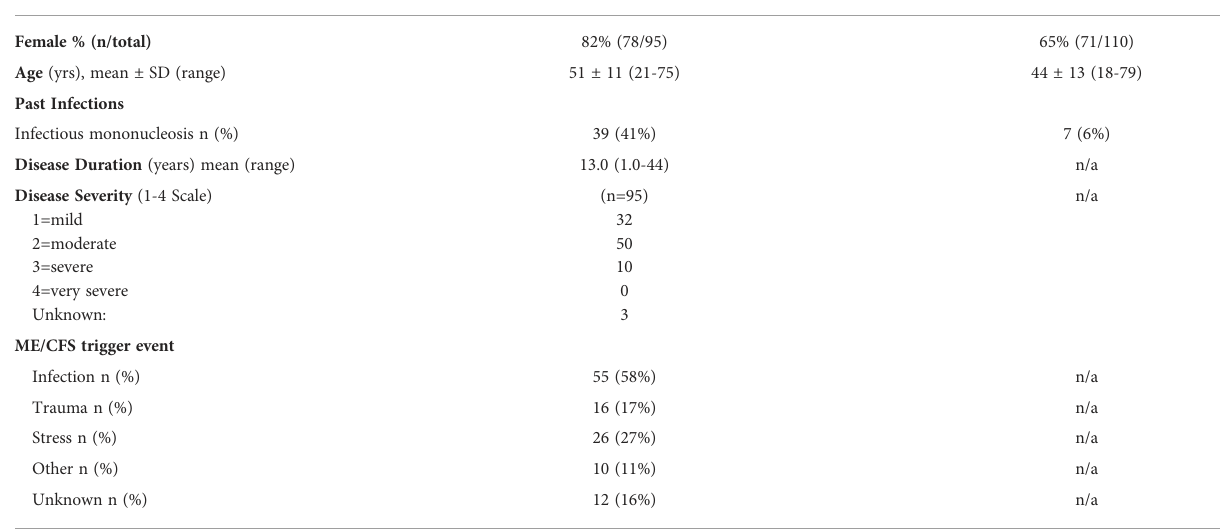
TABLE 1 Demographics and clinical